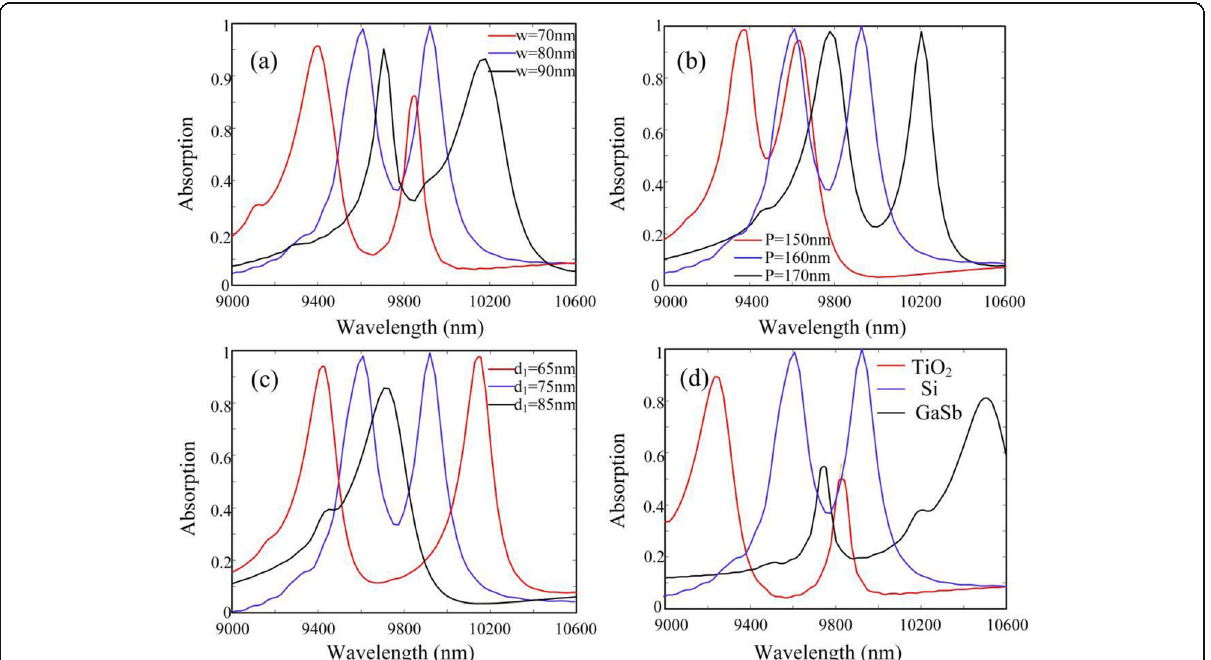
Fig. 7 Light absorption of proposed CPA with different a p , b w , c d 1 , and d different dielectric array, respectively. The other parameters are the same as Fig.